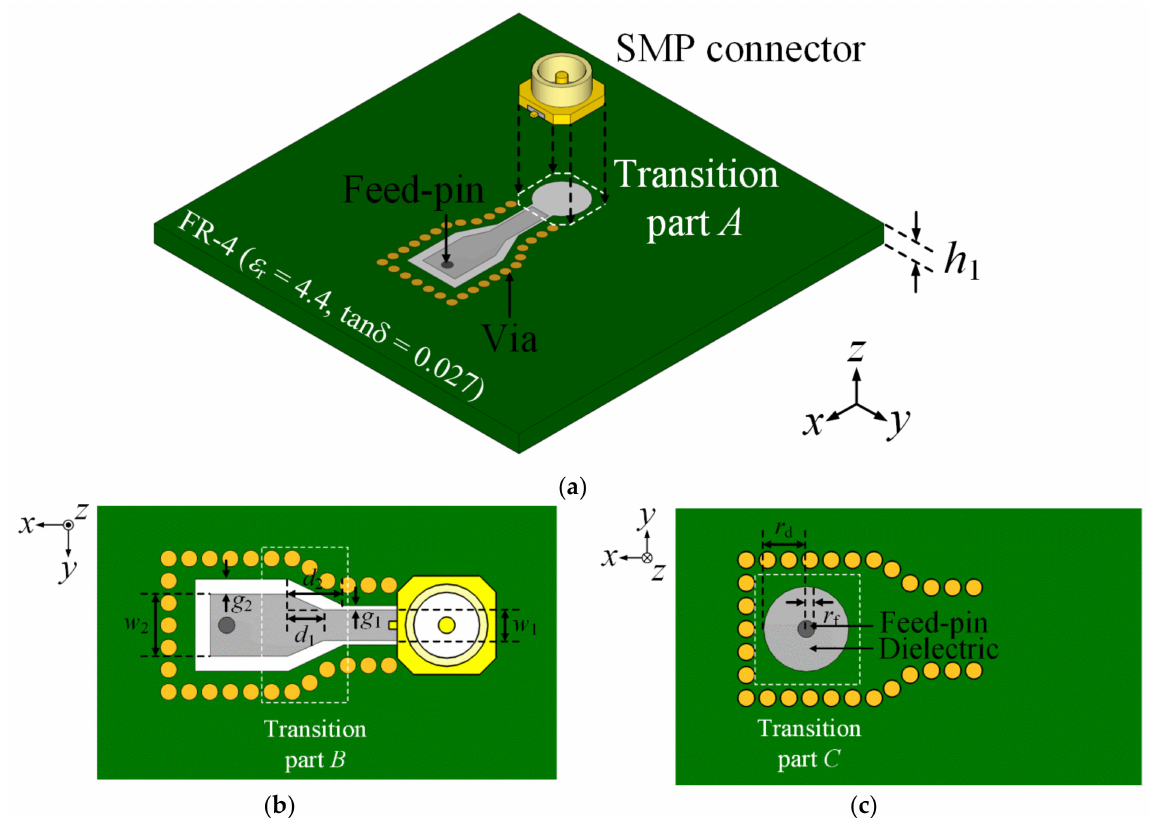
Figure 1. Geometry of the proposed interface layer using the CPW: ( a ) isometric view; ( b ) top view; ( c ) bottom